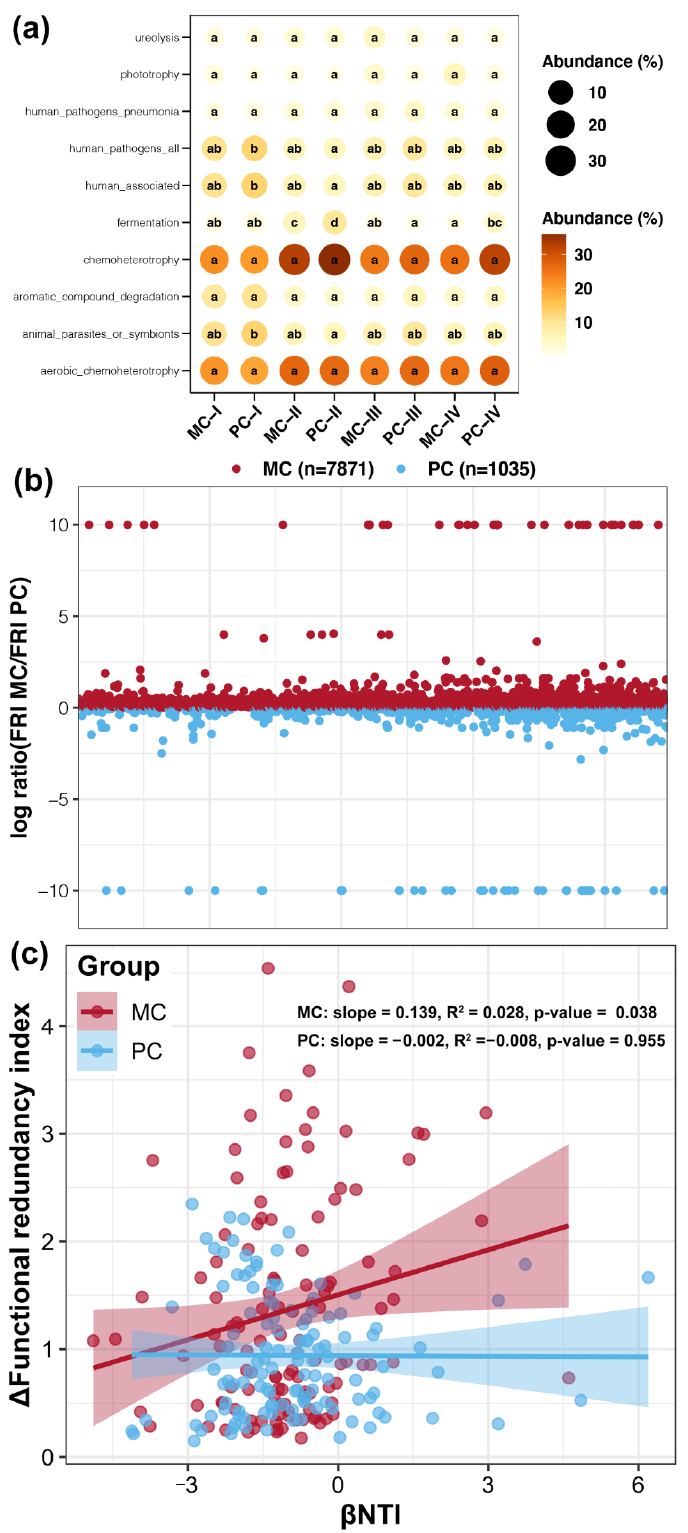
Figure 4. Ecological functions of bacterioplankton communities affected by apex predators. ( a ) Differ- ences in relative abundances of dominant bacterial phyla among different groups. The size of points represents the relative abundance of different bacterial phyla, and different lowercase letters on the internal side of points from the same row represent significant differences between groups